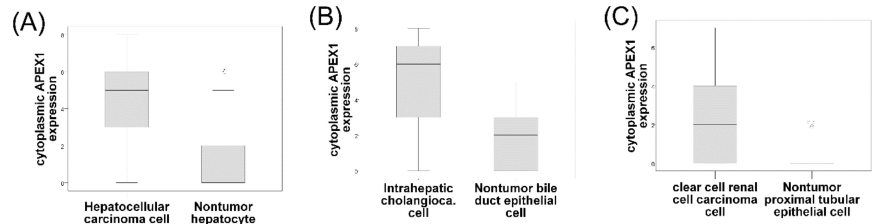
Figure 2. Cytoplasmic expression of the APEX1 protein in 131 paired cases of hepatocellular carcinoma cells and the matched nontumor hepatocytes ( A ), 32 paired cases of intrahepatic cholangiocarcinoma cells and the matched nontumor bile duct epithelial cells ( B ), and 106 paired cases of clear cell renal cell carcinoma cells and the matched nontumor proximal convoluted tubular epithelial cells ( C ), using immunohistochemical staining for formalin-fixed, para ffi n-embedded tissue (Wilcoxon signed-rank test: p < 0.001, each). The line in the middle of the boxes is the median. The box length indicates the interquartile range. The ends of the whiskers represent maximum and minimum values.